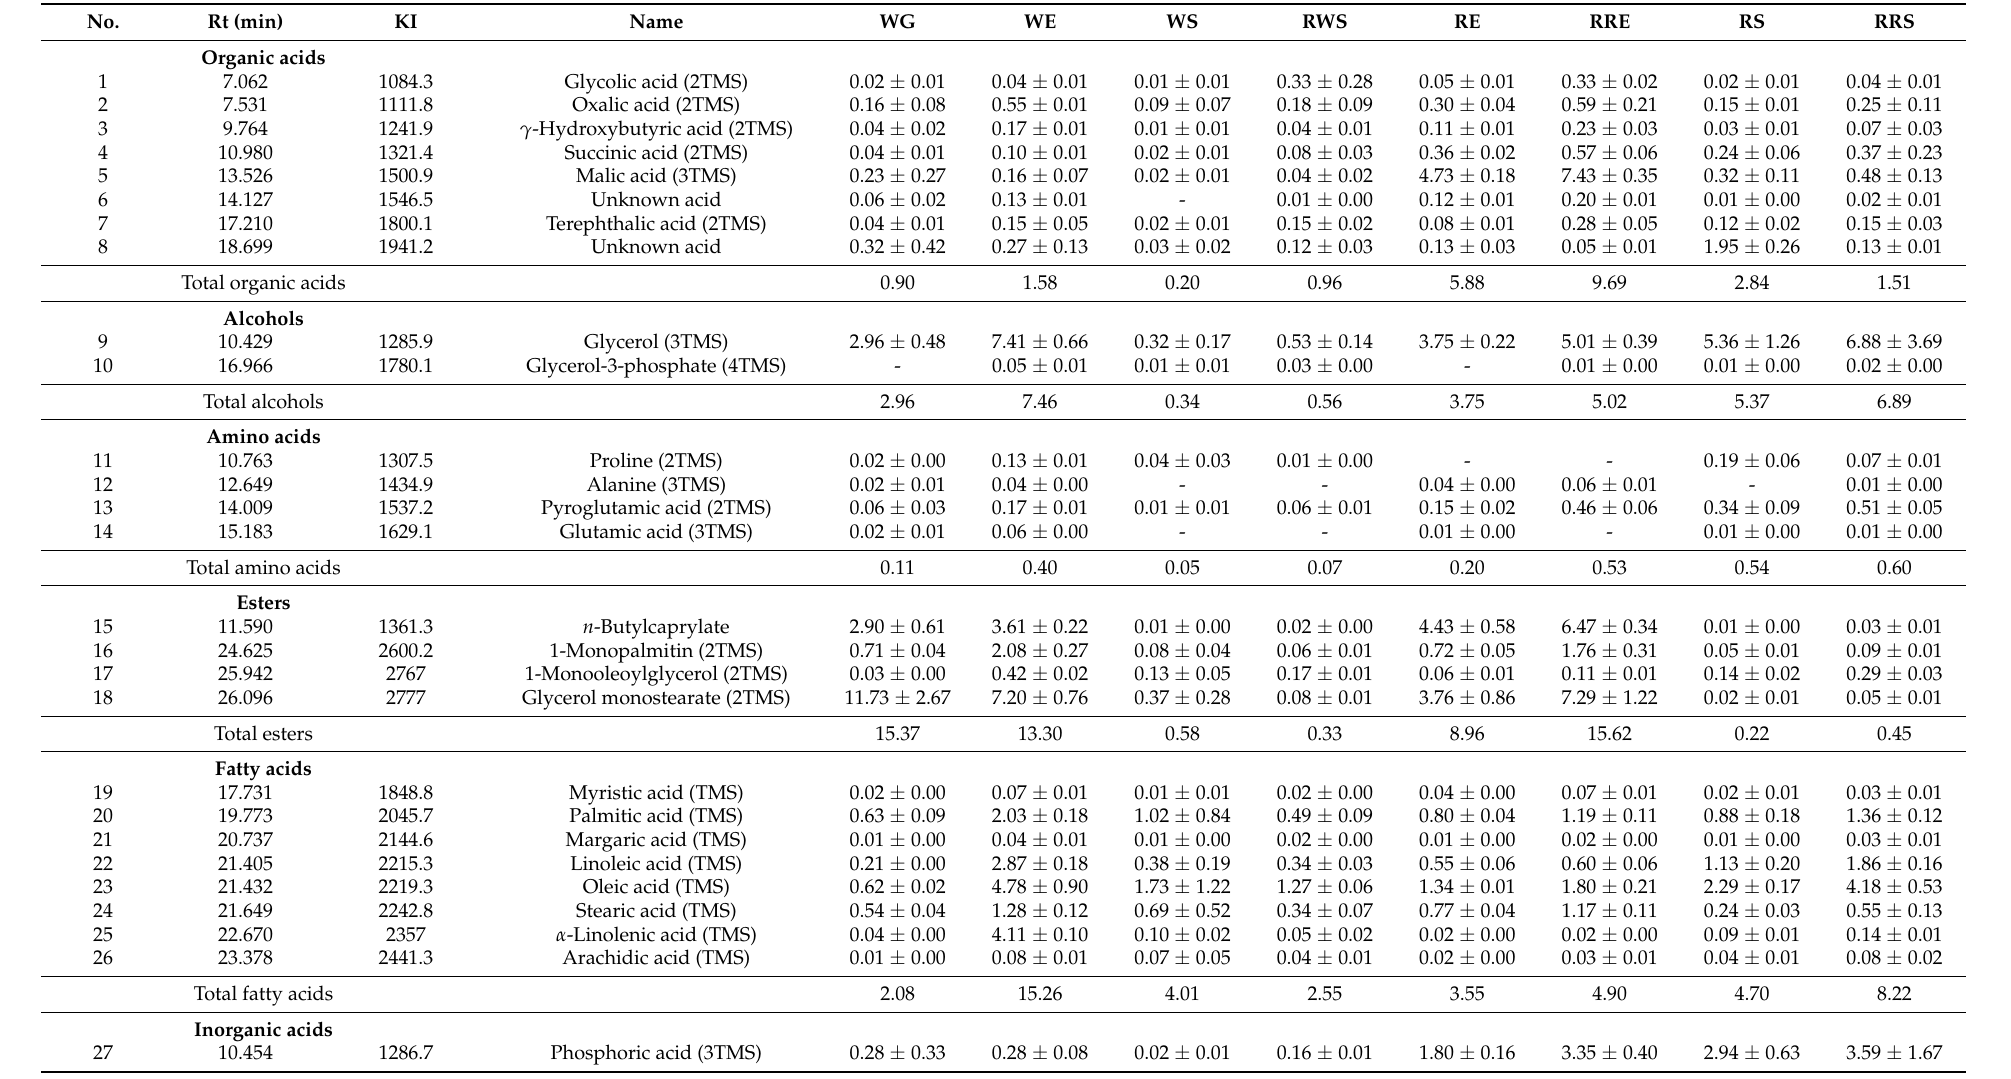
Table 2. Relative percentage of silylated metabolites in P. mahaleb seeds analyzed via GC–MS, n = 3. For codes, refer to Table